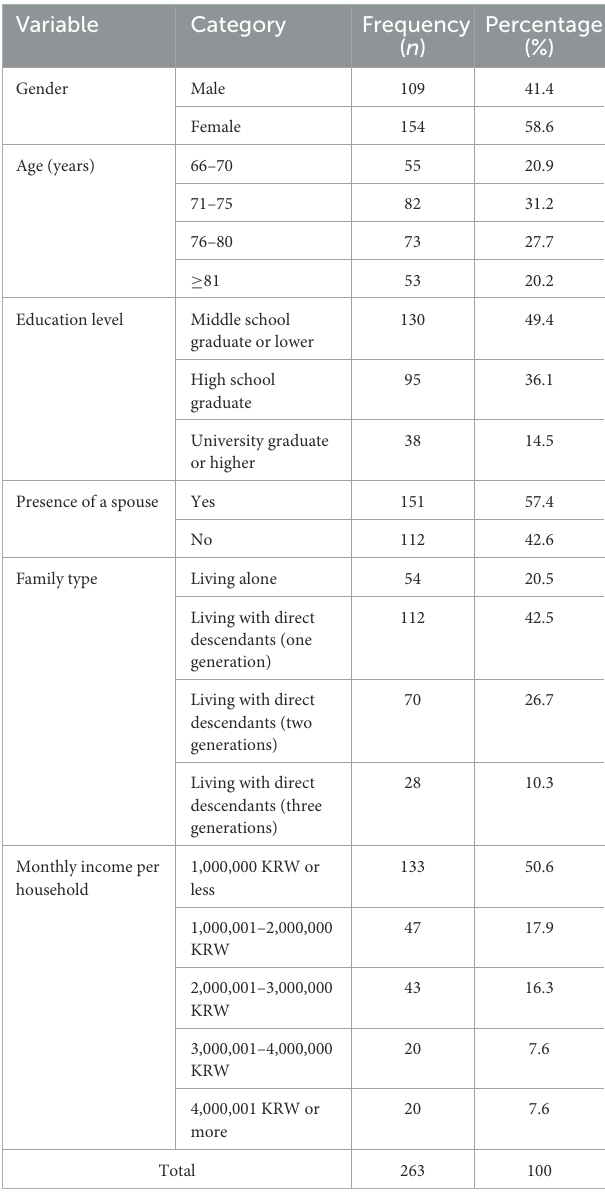
TABLE 1 Participants’ demographic